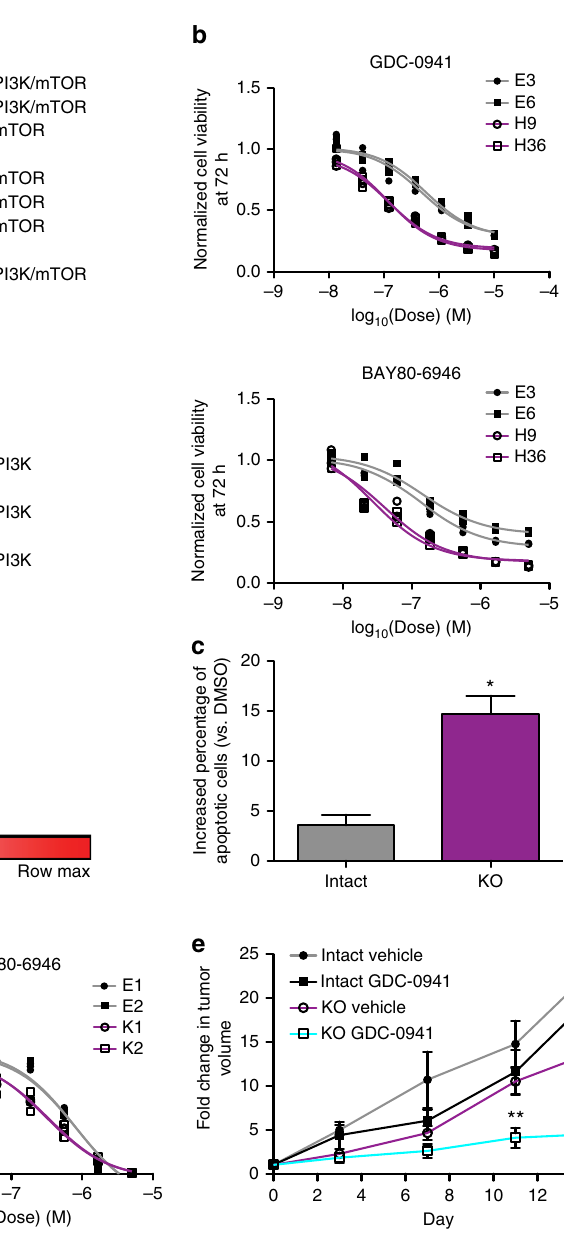
Fig. 3 KRAS de fi cient cells are dependent on PI3K. a Heat map of area under the curve (AUC) for KRAS intact and de fi cient (KO) clones (columns) treated with various compounds. Row normalized data are presented with red designating high AUC (less sensitive) and blue denoting low AUC (more sensitive). Shown are hit compounds (see “ Methods ” section) exhibiting greater sensitivity in KRAS de fi cient cells listed in order of Δ AUC from highest to lowest. PI3K and mTOR inhibitors are noted. See Supplementary Data 4 for full data set. b Dose-response curves of 8988T KRAS intact (gray) and de fi cient (purple) cells to the pan-PI3K inhibitors GDC-0941 and BAY80-6946. Each replicate ( n = 3 for each dose) and curve fi t are shown. c Increased apoptosis (change in percentage Annexin V-positive cells vs. DMSO) in KRAS de fi cient (KO) cells 48 h after 2 μ M GDC-0941 treatment. Average ± s.e.m. is plotted ( n = 2 clones per group). * p < 0.05, two-tailed Student ’ s t test. d Dose-response curves of A13 cells to pan-PI3K inhibitors. Each replicate ( n = 3 for each dose) and curve fi t are shown. e GDC-0941 signi fi cantly decreased the growth rate of KRAS de fi cient (KO) but not intact A13 transplanted tumors in nude mice. Average tumor volume fold increase (normalized to start of treatment at day 0) ± s.e.m. ( n = 8 tumors per group) is plotted. * p < 0.05, ** p < 0.01, two-tailed Student ’ s t test for measurements at each time point comparing GDC-0941 to